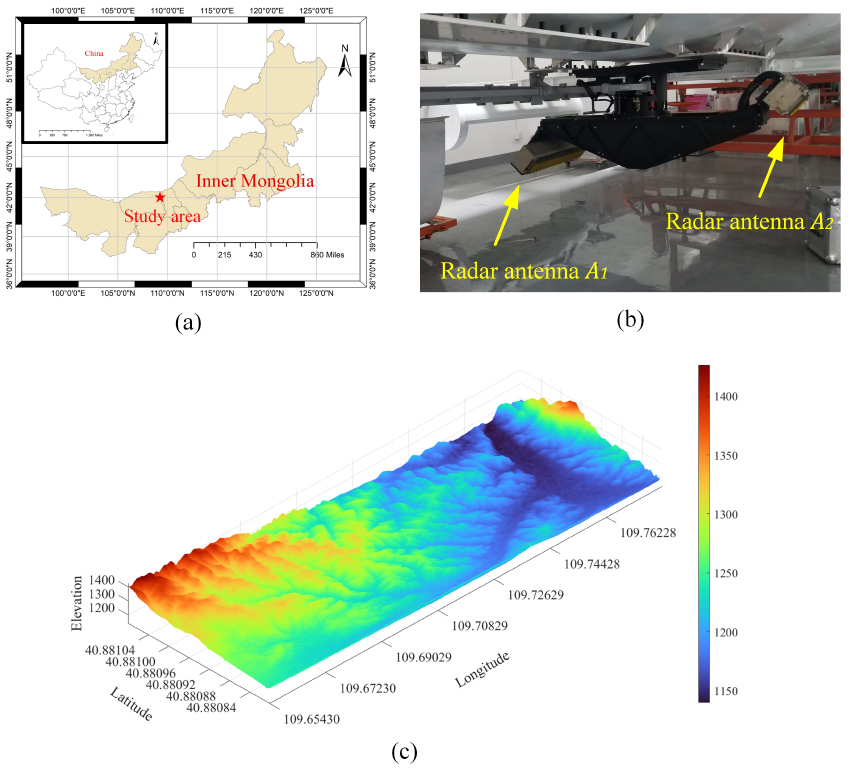
Figure 14. Experimental information. ( a ) Experimental site. ( b ) Radar and antenna. ( c ) DEM as well as longitude and latitude information corresponding to experimental